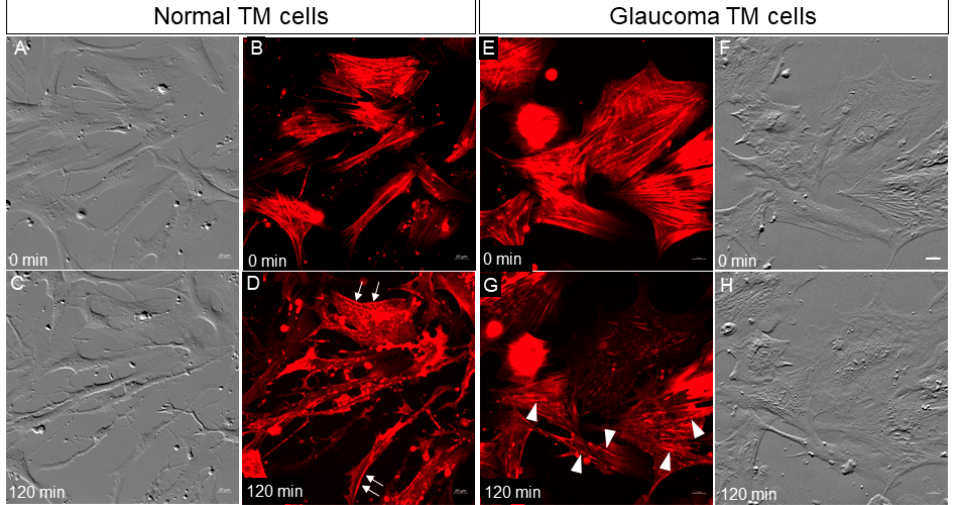
Figure 1. Normal ( A – D ) and glaucomatous ( E – H ) TM cells before (0 min) and 120 min post-treatment with 1 µM netarsudil. Arrows in panel D show that cortical actin was not affected by netarsudil in normal TM (NTM) cells at 120 min. Arrowheads in panel G show partially disassembled stress fibers in glaucomatous TM (GTM) cells. Red = SiR-actin; grey = phase gradient contrast. Scale bar (Panel F) = 20 µm.